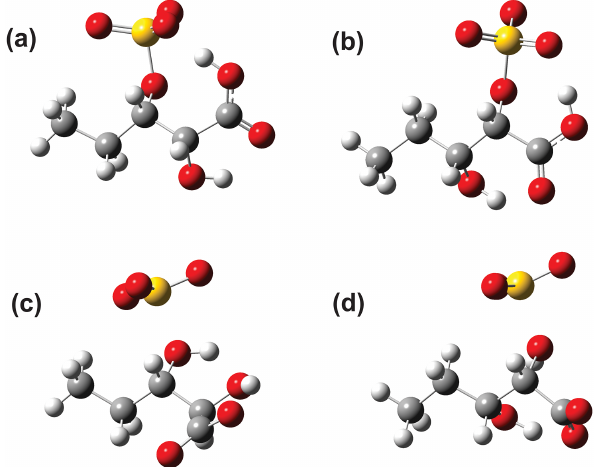
Figure 4. Optimized gas-phase geometries of the lowest- energy conformers of the MW 214 sulfate derivatives of 2,3- dihydroxypentanoic acid with the sulfate group located at (a) C-3 and (b) C-2, and the associated optimized structures ( c, d , respec- tively) after transfer of the carboxyl